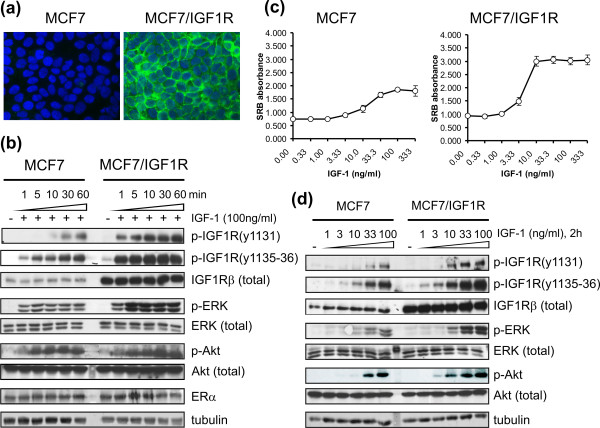
Characterization of insulin-like growth factor 1 receptor overexpression, autophosphorylation, signaling transduction and proliferation of MCF7/insulin-like growth factor 1 receptor cells in response to insulin-like growth factor 1. (a) Immunofluorescence showing insulin-like growth factor 1 receptor (IGF-1R) overexpression in MCF7/IGF-1R cells compared to parental MCF7 cells. IGF-1R was probed with mouse monoclonal antibody against IGF-1Rβ (green). Cell nuclei were stained with 4',6-diamidino-2-phenylindole (blue). Original magnification, × 60. (b) IGF-1R autophosphorylation and signal transduction in time course exposure to IGF-1 (100 ng/mL) for 1, 5, 10, 30 and 60 minutes. ERα, estrogen receptor. (c) Proliferative response of MCF7 versus MCF7/IGF-1R cells to IGF-1 stimulation at the dose ranges indicated. Sulforhodamine B (SRB) absorbance values (optical density (OD) 510 nm) are representative of three independent experiments. Data are expressed as means ± SD. (d) IGF-1R autoactivation and signal transduction to IGF-1 exposure at various dose levels (1, 3, 10, 33 and 100 ng/mL) for two hours. Total IGF-1R levels were detected by IGF-1Rβ antibody at 97 kDa. IGF-1R triple tyrosine phosphorylation was determined by using phospho-IGF-1Rβ (Tyr1131) and phospho-IGF-1Rβ (Tyr1135/Tyr1136) rabbit antibodies. Phosphorylated extracellular signal-regulated kinase (p-ERK) and phosphorylated protein kinase B (p-Akt) were determined by using p-ERK1/2 and p-Akt antibodies, respectively. The status of the estrogen receptor (ER) was detected by rabbit anti-ERα antibody. Tubulin was detected as a control for protein loading.